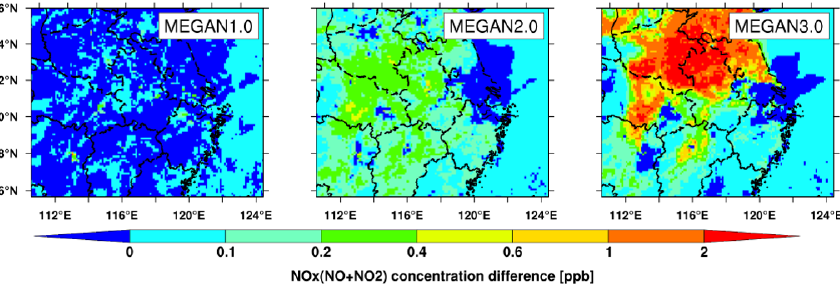
Figure 13. Spatial distribution of NO x concentration due to the biogenic emissions near the surface (the difference between the simulation that considered biogenic emissions and the one without biogenic emissions) in July using the VEG-2015 vegetation date